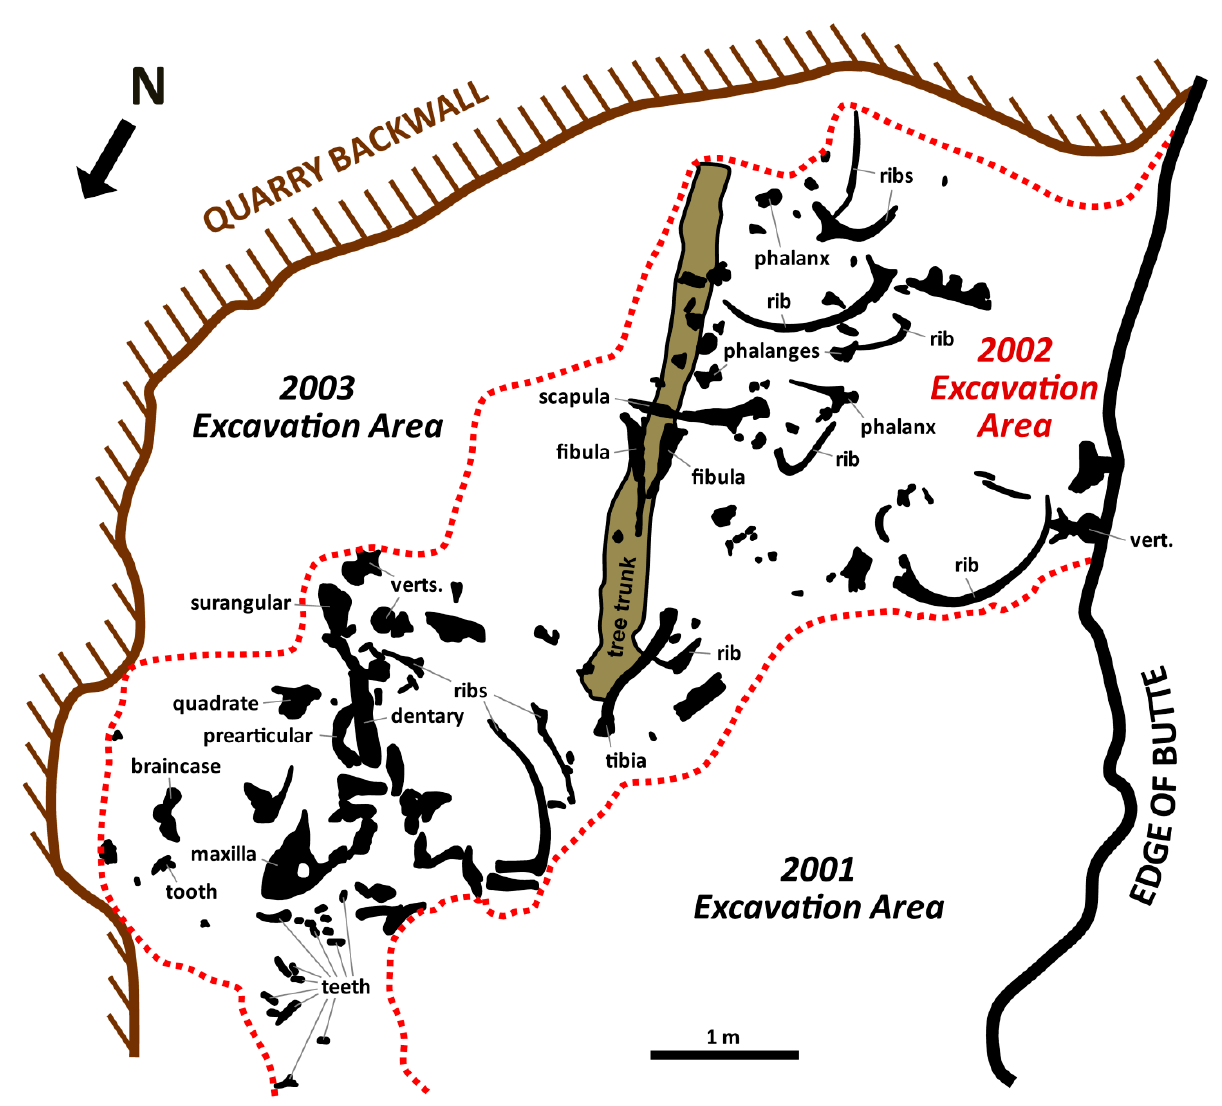
Figure 2. Quarry map from the 2002 field season at the MOR 1125 quarry. Only bones discovered during that field season are shown. Select identifiable bones are identified as labeled. Although the large tree trunk was found above all the bones in the central region of the quarry, it is shown behind them to allow the bones to be better seen. Scale bar as indicated.